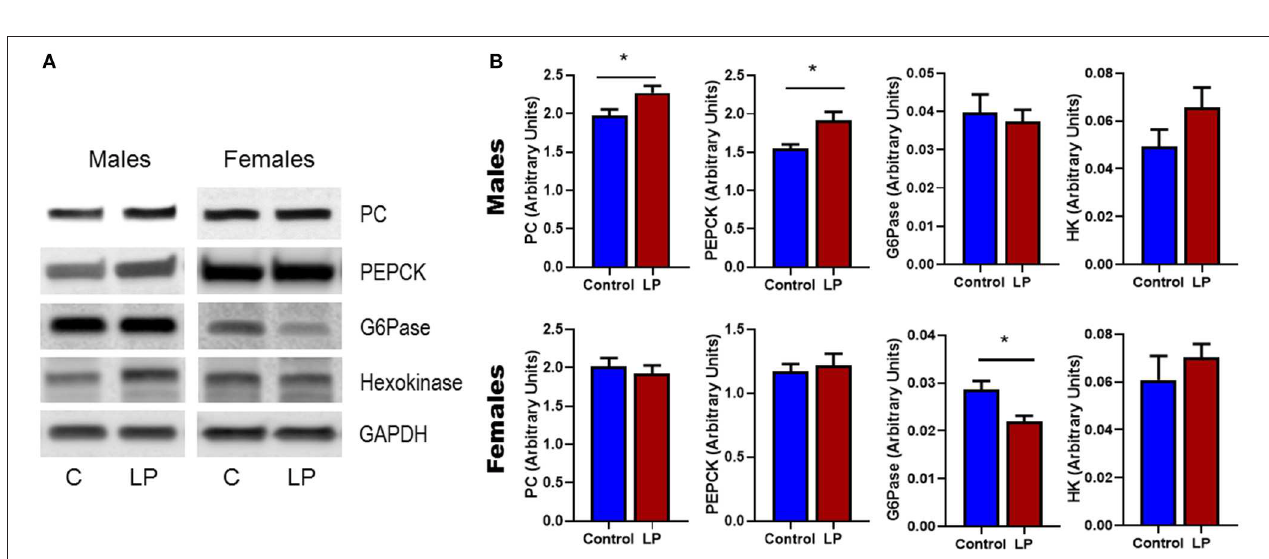
FIGURE 7 | Western Blots (A) and its corresponding desitometric analysis (B) showing the protein levels of key enzymes related to glucose metabolism in control and low protein programmed lean type 2 diabetic (LP) in male and female rats. * p < 0.05, n = 4–6.